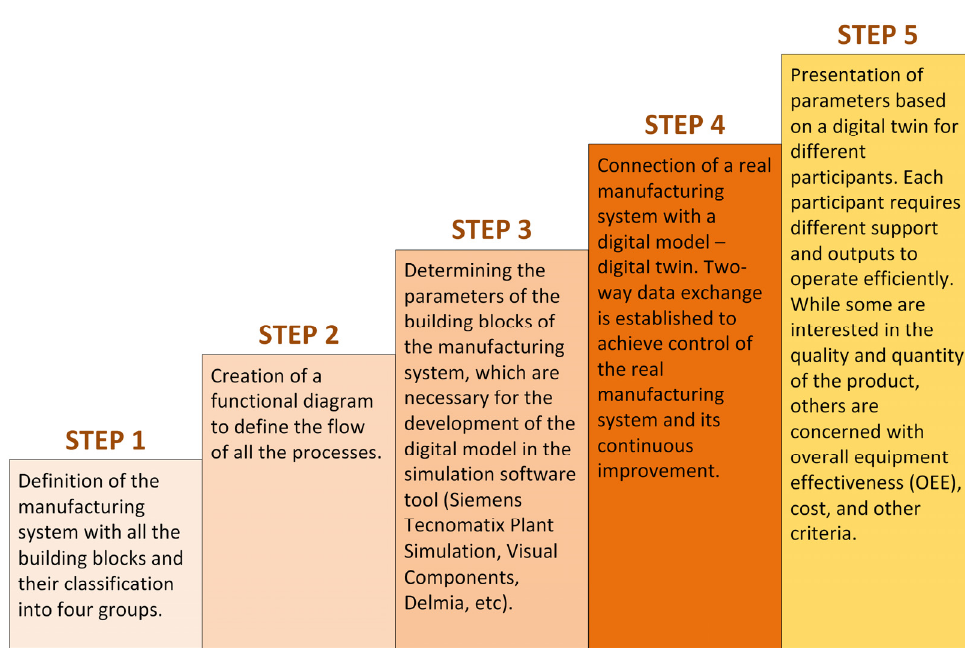
Figure 2. Our five-step approach that guides the users from the starting point to the usage of the digital twin.